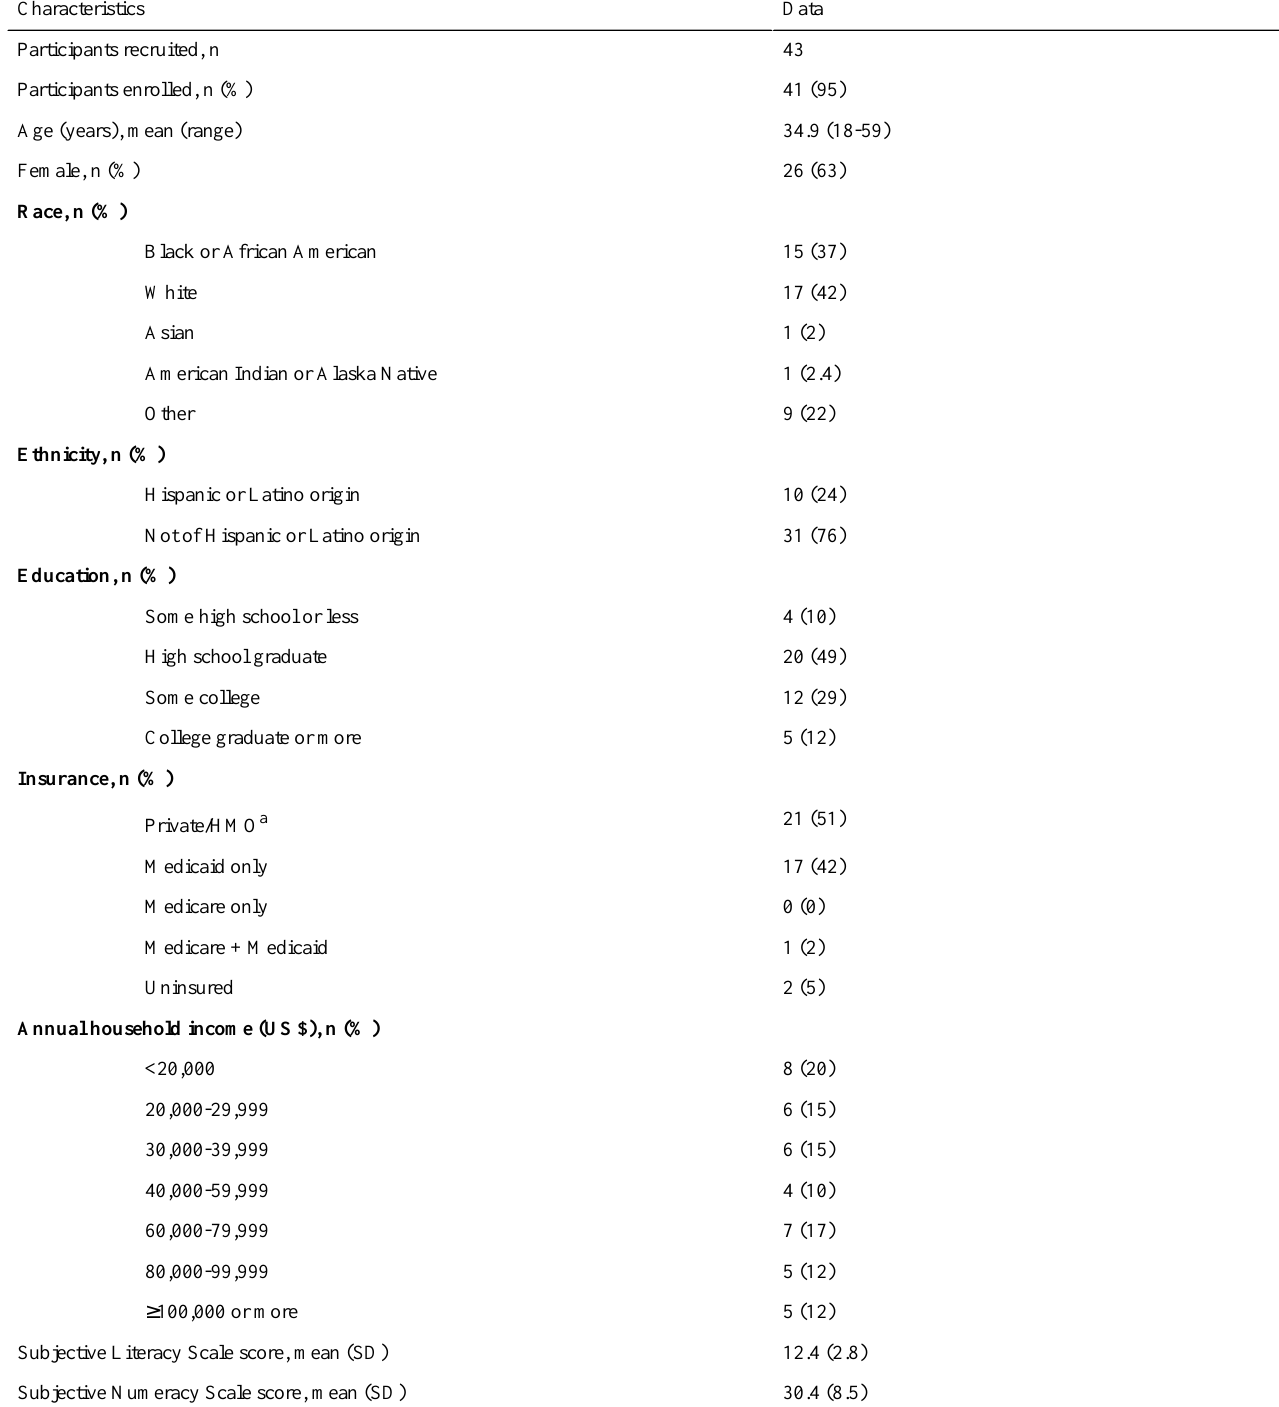
Table 1. Patient